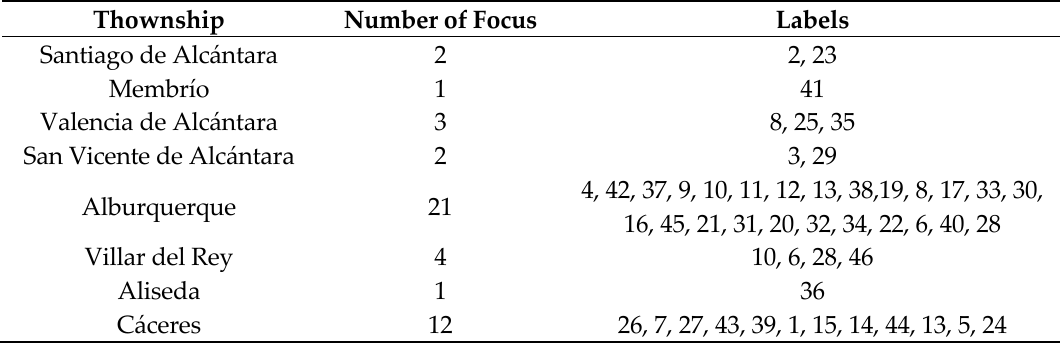
Figure 1. ( a ) Vor(P) and Voronoi regions (cell) in “Sierra de San Pedro” obtained using the ‘’seca” focus as generators (sites) of the diagram. They are labeled with numbers from 1 to 46. The townships where they were prescribed are included in Table 1. ( b ) Voronoi regions, sites (Phytophthora cinnamomi focus in Holm oak) and Voronoi vertices of Vor(P) overprinted on the affected areas. Table 1. Number of focus of the disease and places where they are located. The corresponding label employed in the diagram (see Figure 1) are also shown. Information on the focus and their location has been extracted from